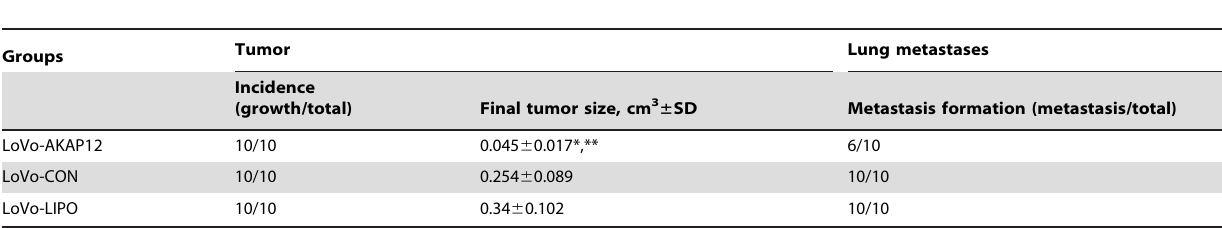
Table 1. Growth and metastatic ability of non-transfected and transfected LoVo cells in vivo .